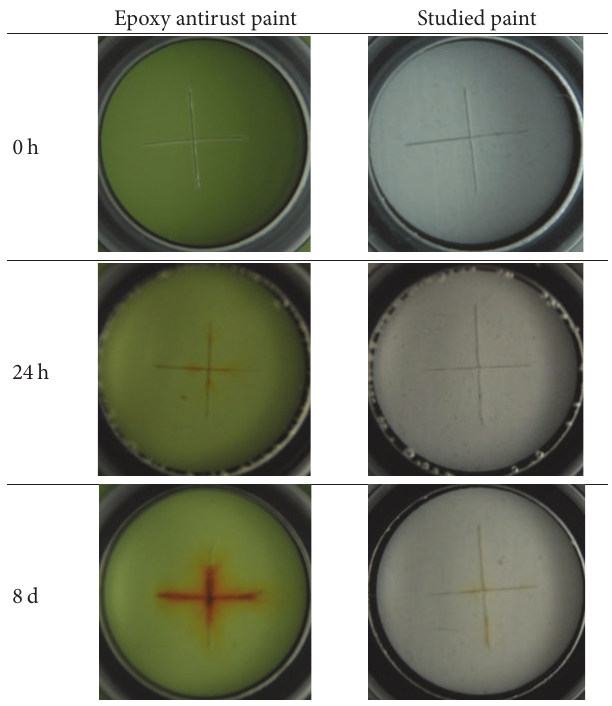
Table 2: Immersion testing results for scratched coating samples after different